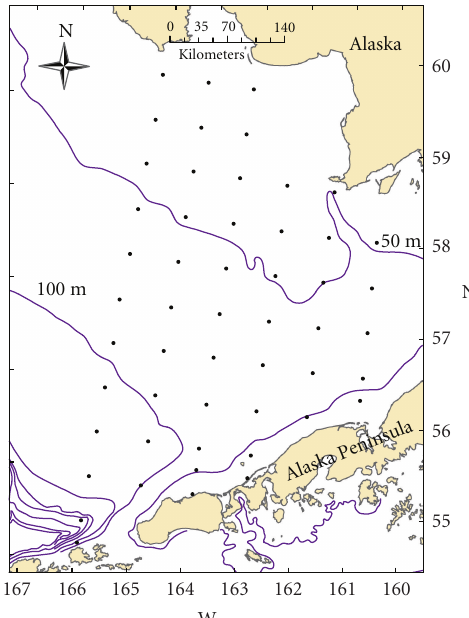
Figure 1: Approximate station locations where trawl sampling for juvenile sockeye salmon occurred during August–September from 2000 to 2006 Ocean Carrying Capacity, BASIS research